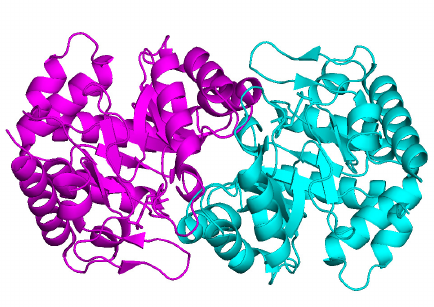
Figure 10. PDB deposited model of 2V30. The 2-fold NCS axis is perpendicular to the plane of the